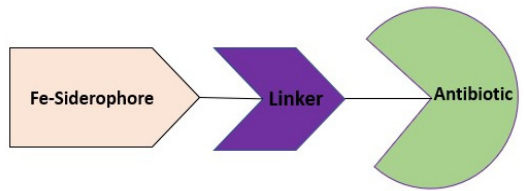
Figure 9. Antibiotics conjugated with Figure 9 . Antibiotics conjugated with siderophores.